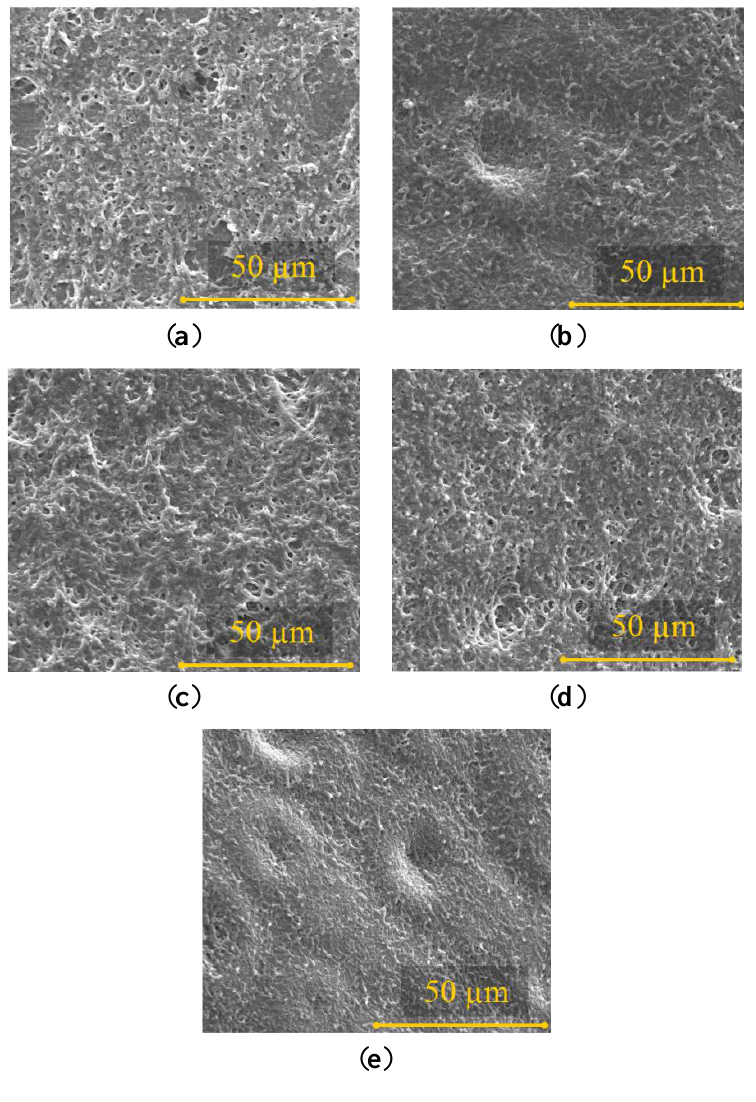
Figure 7. SEM images of the membrane surface after long term diffusion test: ( a ) Bare